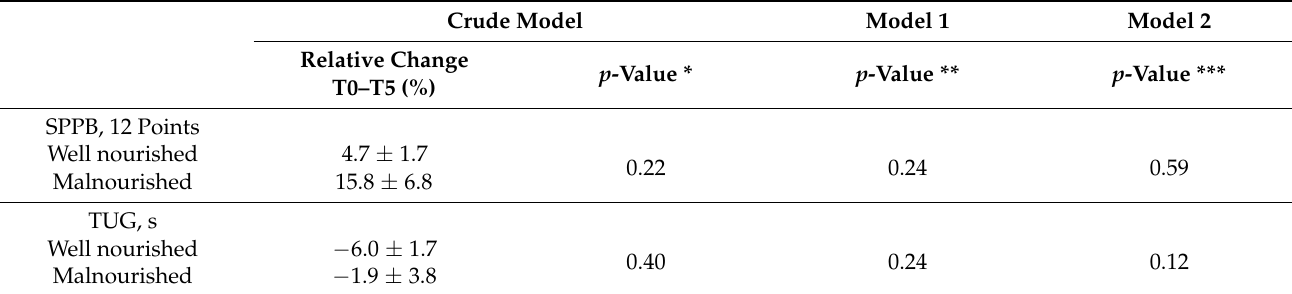
Table 4. Relative change over time of physical performance over a five-year period according to the nutritional status ( n =